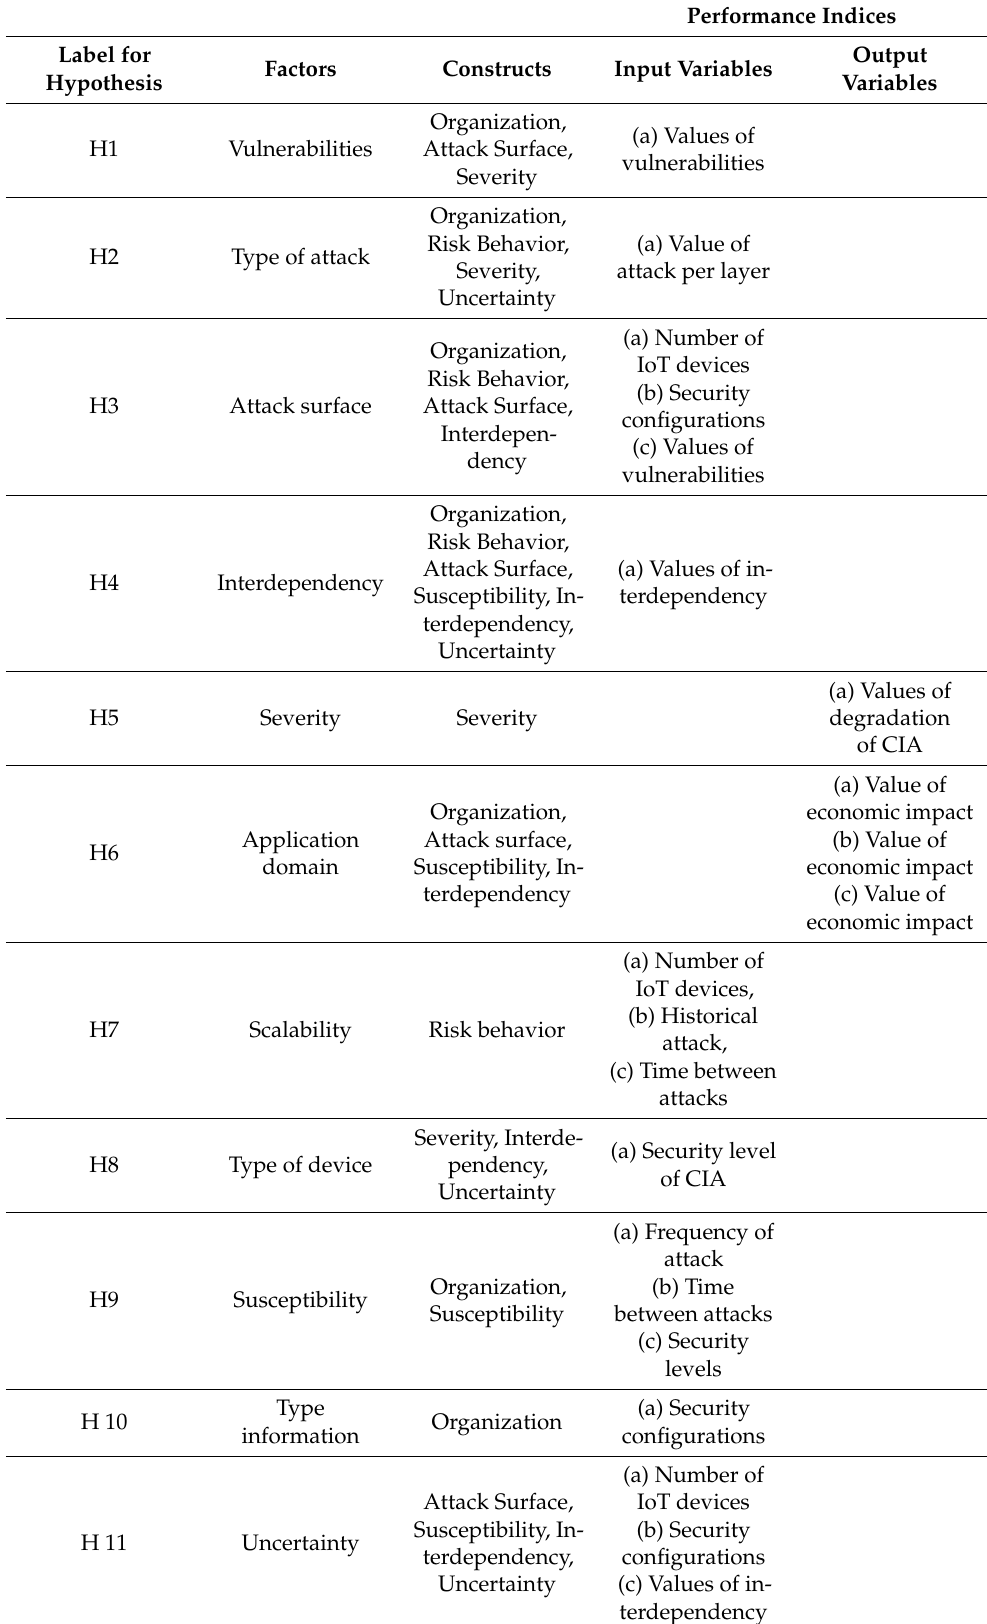
Table 10. Performance indices for the benchmark of risk